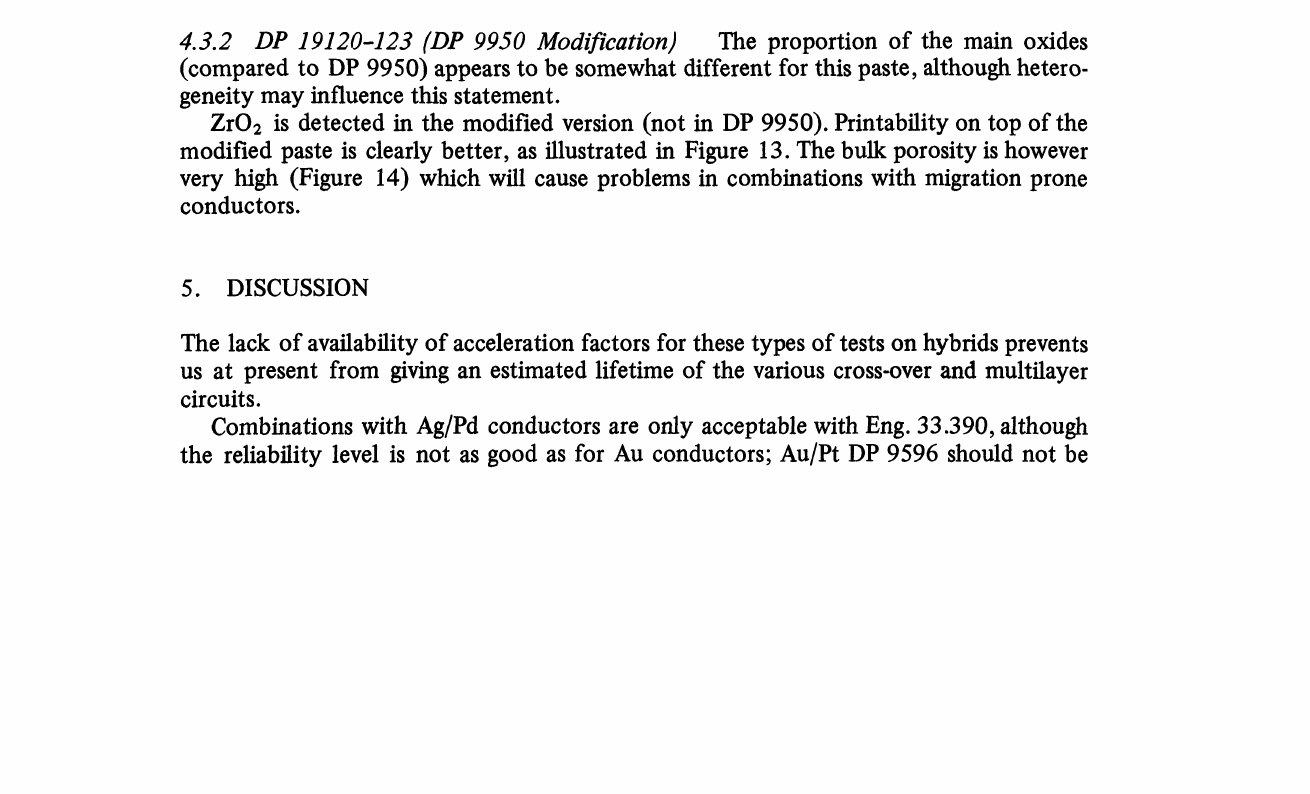
FIGURE 8 Results of humidity tests on various materials, glaze DP 9137, no encapsulation, DP 9137, encapsulation Durez 9841.